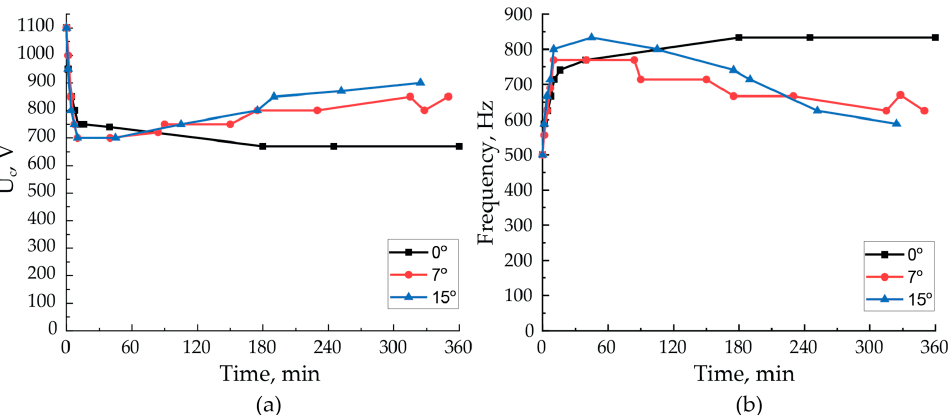
Figure 6. The dependences of ( a ) the capacitor charging voltage and ( b ) frequency of the capacitor discharges for the case of synthesis with the ODP for electrodes’ ends located parallel and at angles of 7° and 15°.